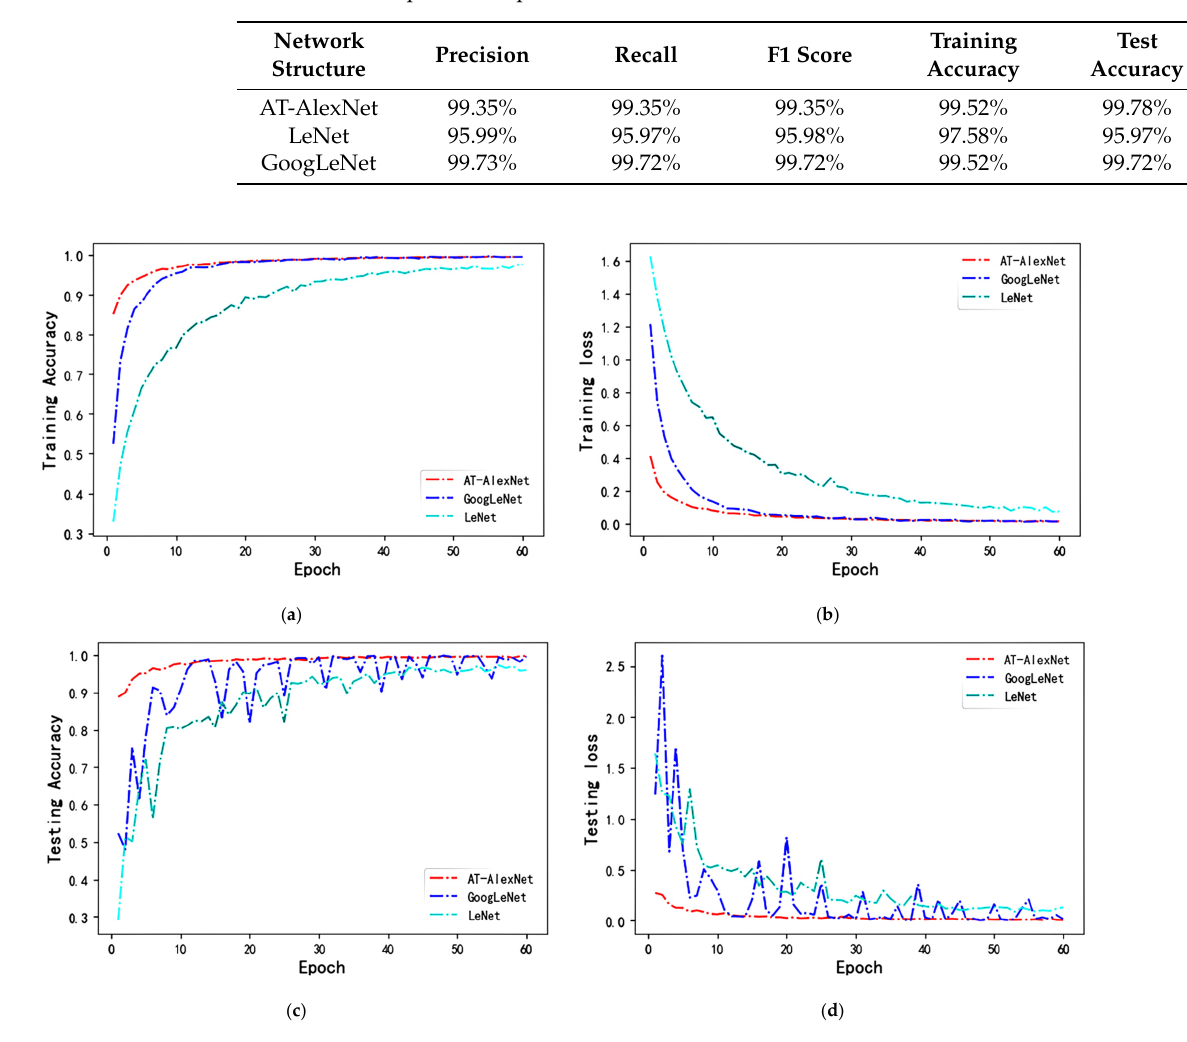
Figure 11. Accuracy and loss value curves of different model training and testing. ( a ) Training accuracy; ( b ) Training loss; ( c ) Testing accuracy; ( d ) Testing loss.